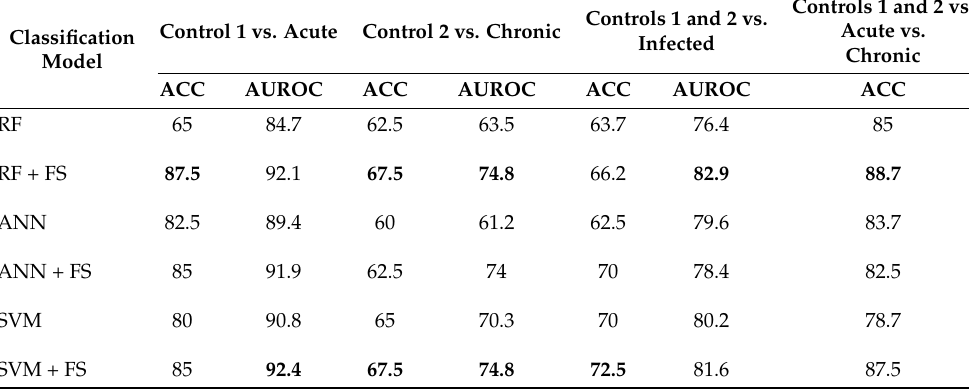
Table 5. Final test results with computationally augmented data. The best classification results are presented in bold, where all performances are shown as a percentage